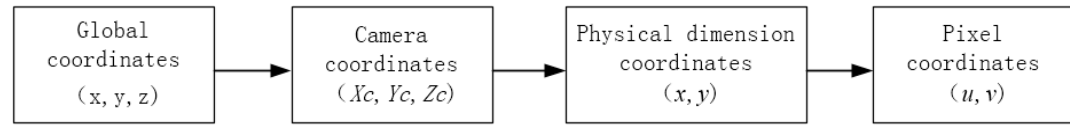
Figure 5. Flow chart of coordinate transformation.